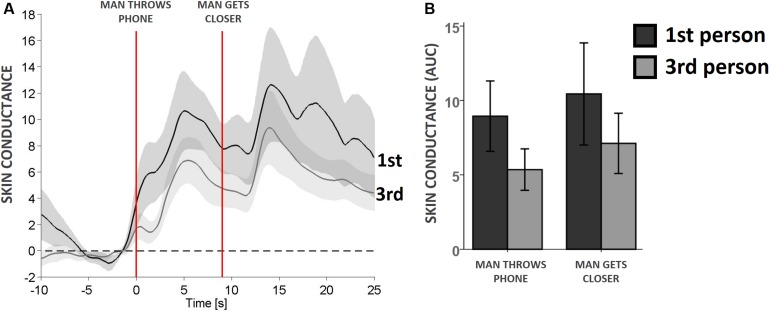
Experiencing a virtual abuse scene from the perspective of a female victim induces slightly stronger physiological reactions to threatening stimuli than does experiencing it as an observer. (A) Skin conductance response of participants assigned to the victim’s (first, dark gray) and an observer’s (third, light gray) perspectives around two selected virtual threatening events: when the man throws the phone in the woman’s direction (onset at leftmost red vertical line), and when the man gets closer to the woman in a threatening manner (onset at rightmost red vertical line). Line, average; shade, standard error. (B) Quantification of the skin conductance response at the two events. ANOVA did not reveal significant differences. AUC, area under the curve (see section Materials and Methods: Physiological Measures for details).